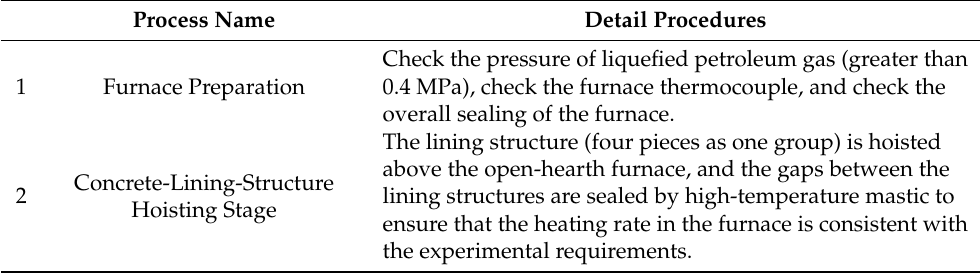
Table 1. The detail process of the burning experiment of the concrete lining